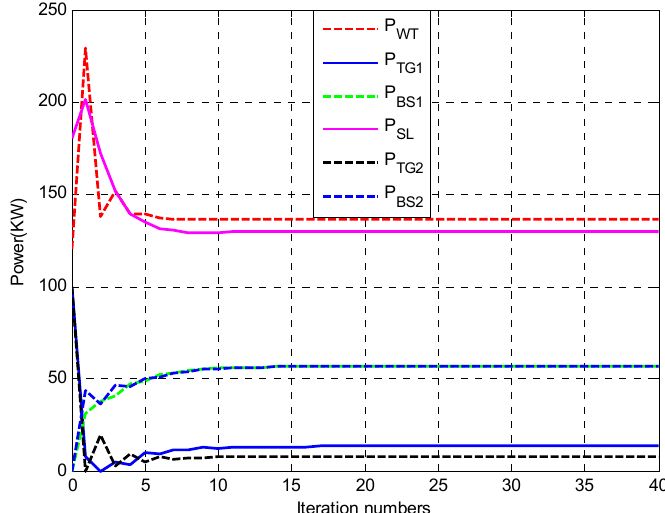
/ DC hybrid microgrid.